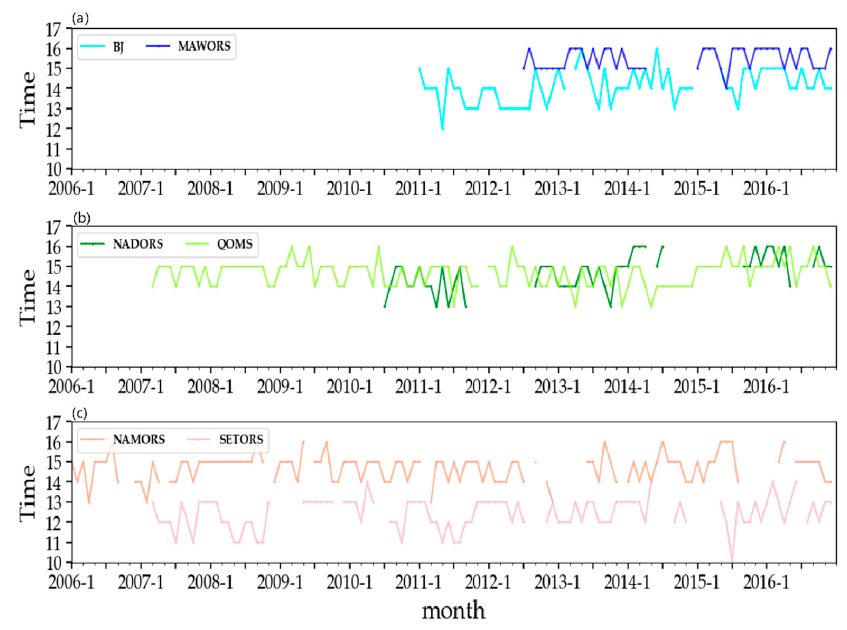
Figure 5. Peak timing (hour) of monthly diurnal variation in SH at ( a ) BJ and MAWORS, ( b ) NADORS and QOMS, and ( c ) NAMORS and SETORS. Table 2. The month and the specific timing of the occurrence of the two large centers in SH diurnal variation at six stations from 2006 to 2016.